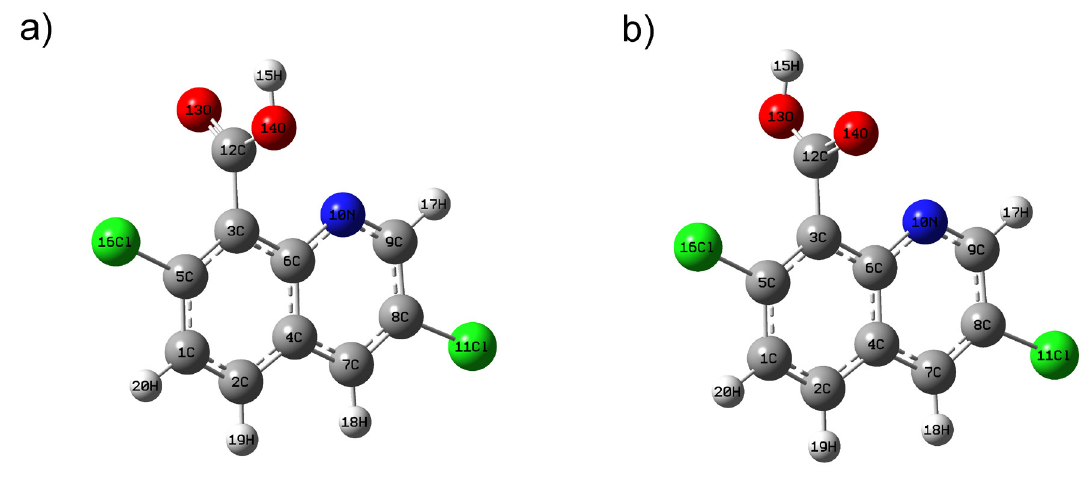
Figure 2: Optimized structures of quinclorac in the gas phase at B3LYP/6-311++G(2d,2p). a) conformer I with the bond distances of 1C-2C=1.37 (1.37), 2C-4C=1.42 (1.42), 4C-7C=1.41 (1.41), 7C-8C=1.37 (1.37), 8C-11Cl=1.75 (1.74), 8C-9C=1.41 (1.41), 9C-10N=1.31 (1.32), 10N-6C=1.36 (1.37), 6C-3C=1.42 (1.42), 3C-5C=1.37 (1.38), 5C-16Cl=1.76 (1.74), 3C-12C=1.50 (1.49), 12C-13O=1.21 (1.21), 12C-14O=1.35 (1.34), 14O-15H=0.99 (0.97), 9C-17H=1.09 (1.08), 7C-18H=1.08 (1.08), 2C-19H=1.08 (1.08), 1C-20H=1.08 (1.08), Angle=13O-12C-14O=123.9 (124.4), b) structure of conformer II, all bond distances are similar to structure I. The MP2 bond distances are reported in